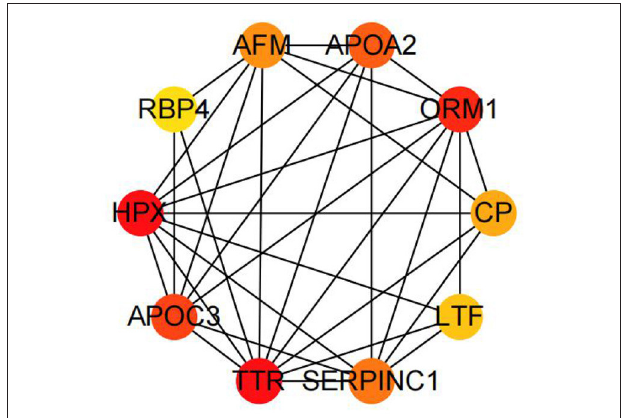
FIGURE 5 | The top 10 hub genes by cytoHubba in the DEGs between the AR and ER